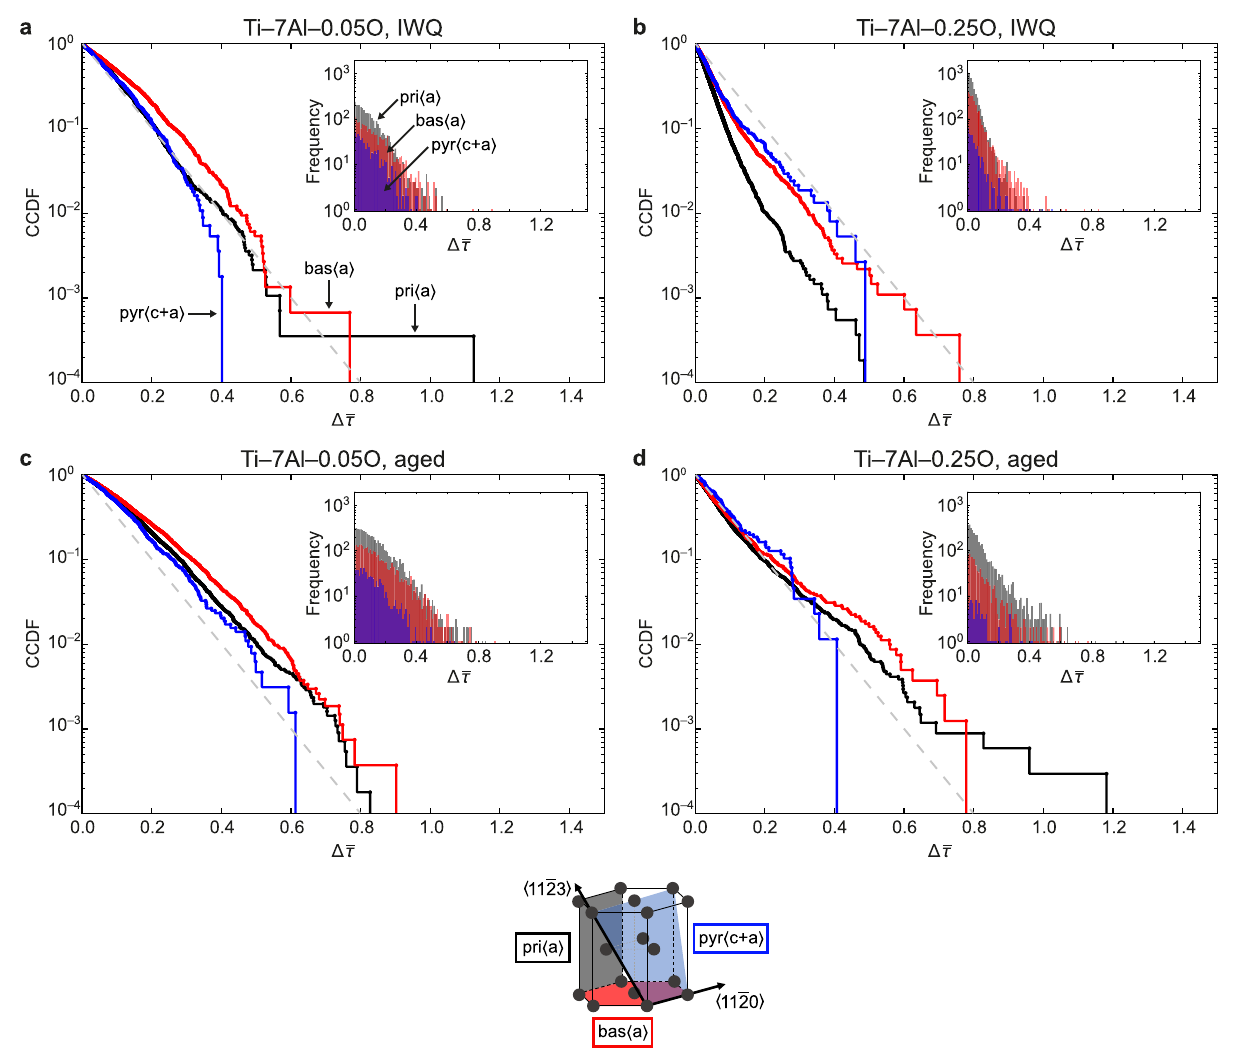
Fig. 4 | Statistical analysis of the ff-HEDM data. Cumulative complementary distribution functions (CCDFs) and histograms (inset) show the distribution of stress drop event sizes, Δ (cid:1) τ . In each case, several thousand stress drop events are captured, in a ratio of approximately 2.5:1:0.1 prismatic:basal:pyramidal. The grey dashed lines are a guide to the eye, and the schematic unit cell provides a key for the slip systems shown. In each case, bas 〈 a 〉 events are coarser than pri 〈 a